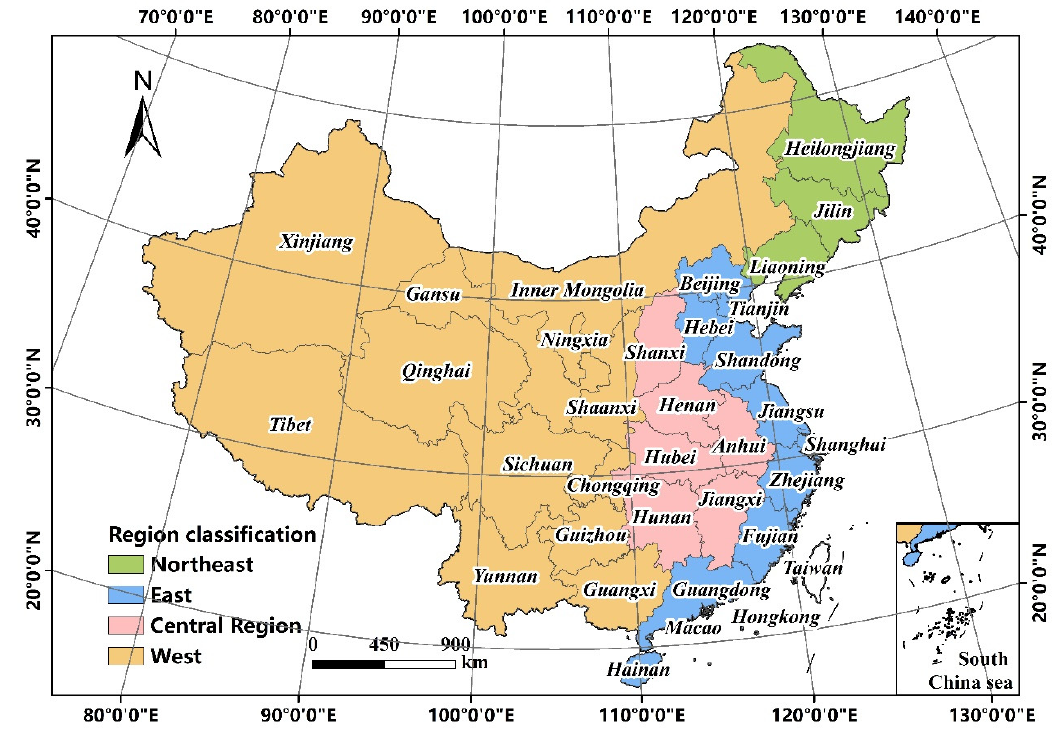
Figure 1. Research scope and regional classification.